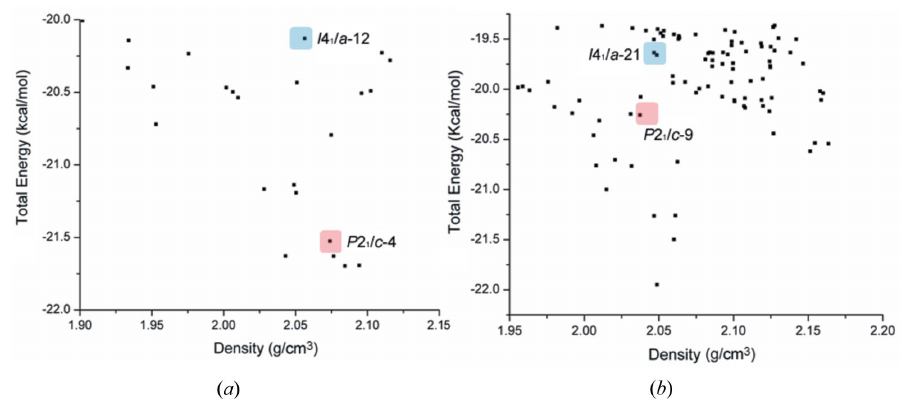
Figure 5 ( a ) Energy landscape for ( 2 ) with experimental structure of ( 2 ) highlighted in blue and the nearest match to structure ( 3 ) in red. ( b ) Energy landscape for ( 3 ) with the experimental structure of ( 3 ) highlighted in red and hypothetical structure similar to ( 2 ) in